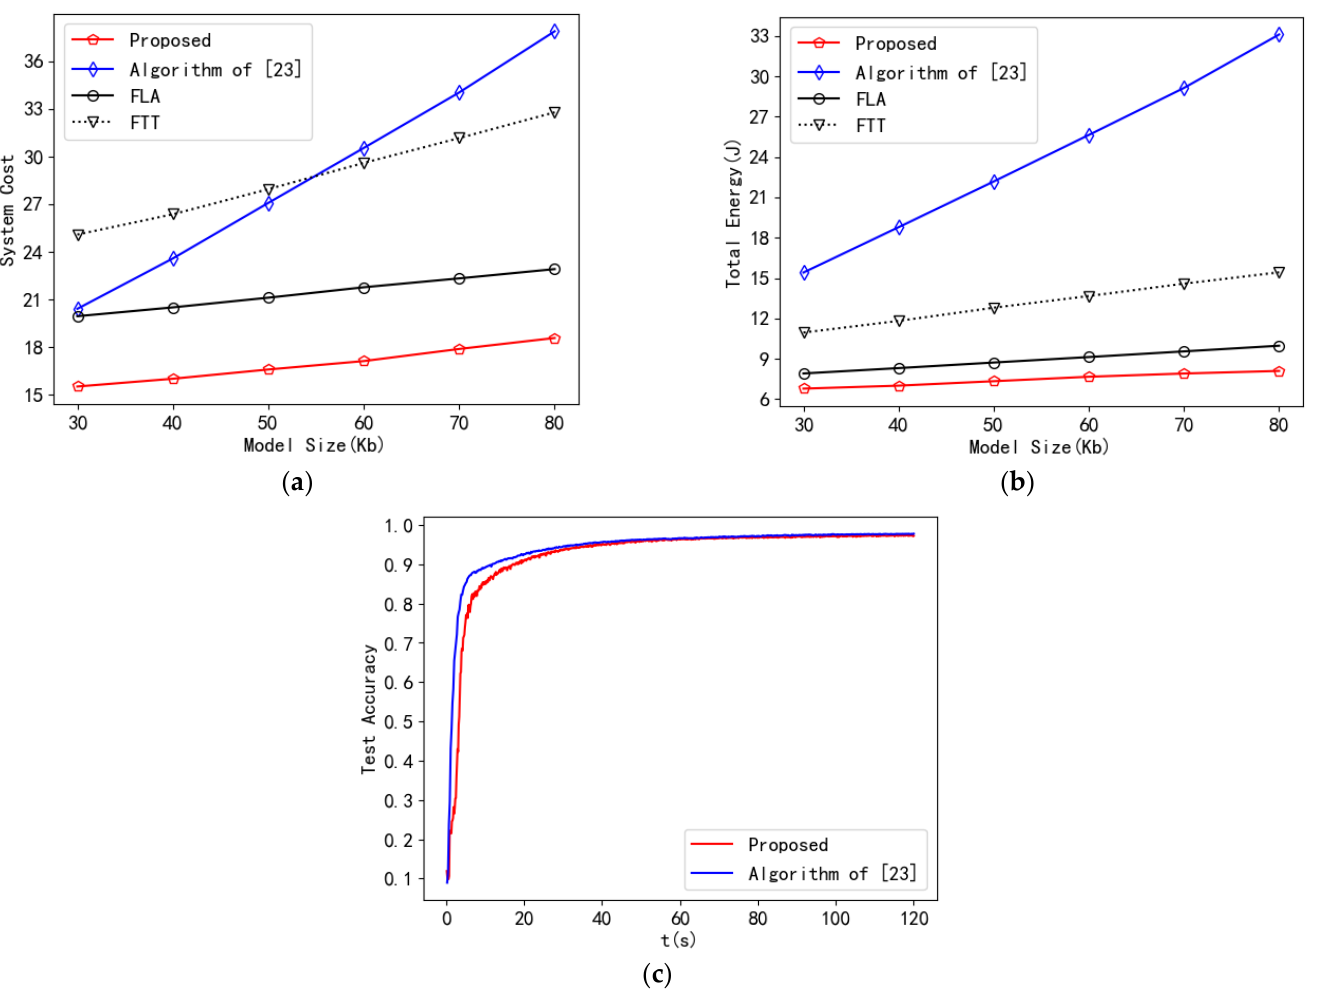
Figure 5. Model Size Influence on Performance: ( a ) total system cost; ( b ) total energy consumption of users; ( c ) learning performance.